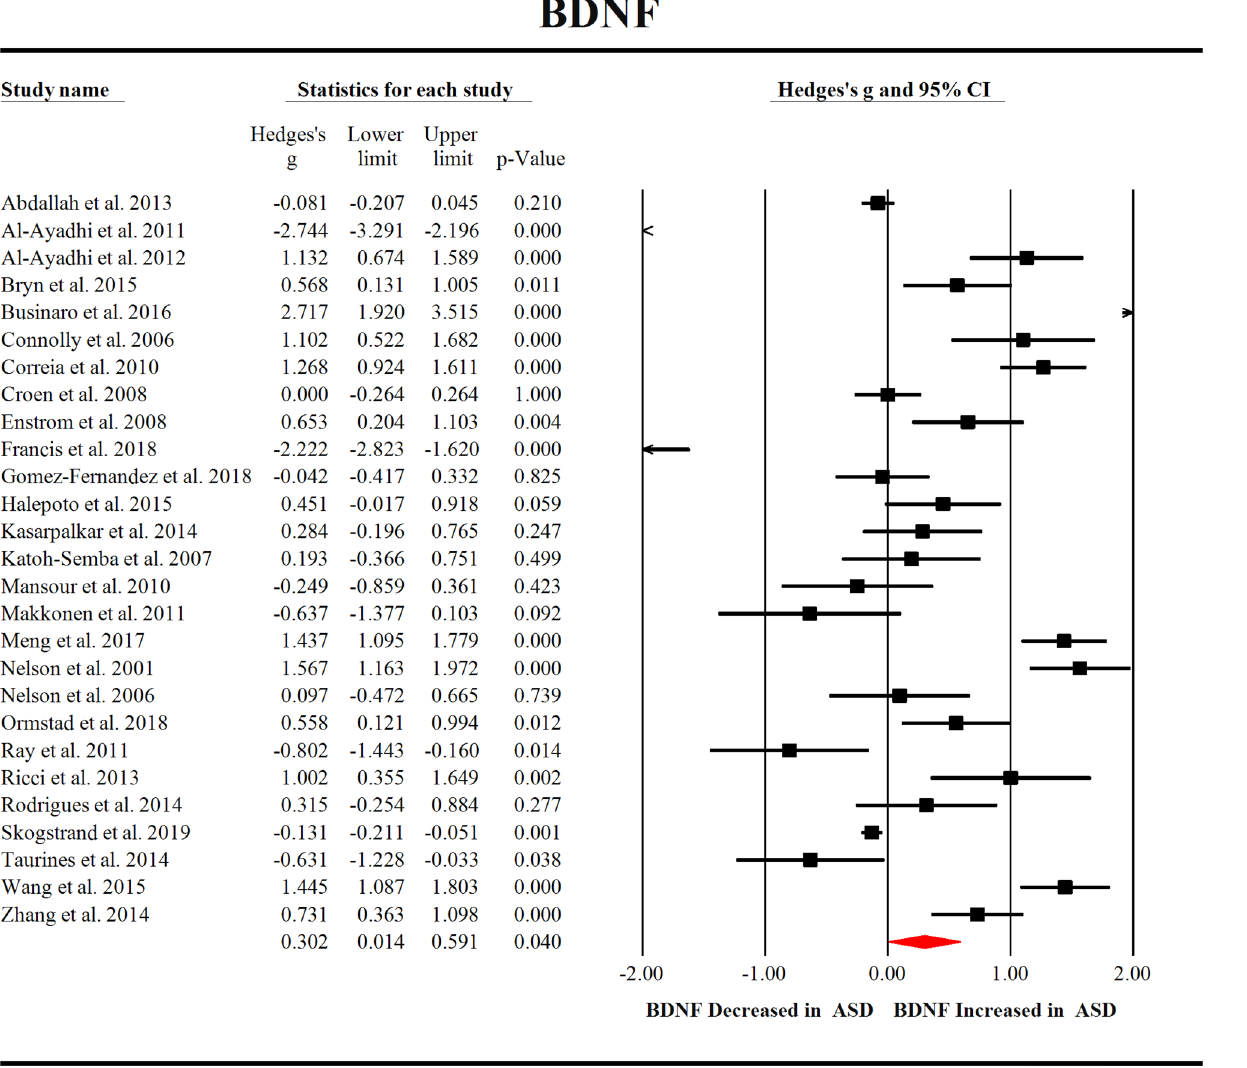
Figure 2. Forest plot for random-effects meta-analysis for BDNF. Forest plot for random-effects meta-analysis on differences in blood BDNF concentrations between children with autism spectrum disorder (ASD) and healthy controls. The sizes of the squares are proportional to study weight. Diamond marker indicates pooled effect size. CI, confidence